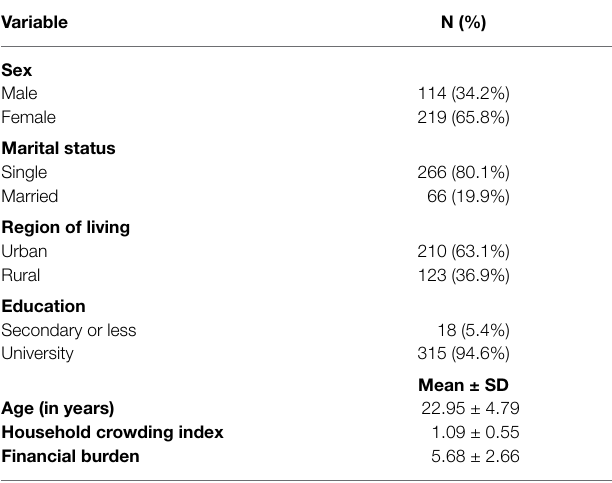
TABLE 1 | Sociodemographic and other characteristics of the participants ( N = 333).